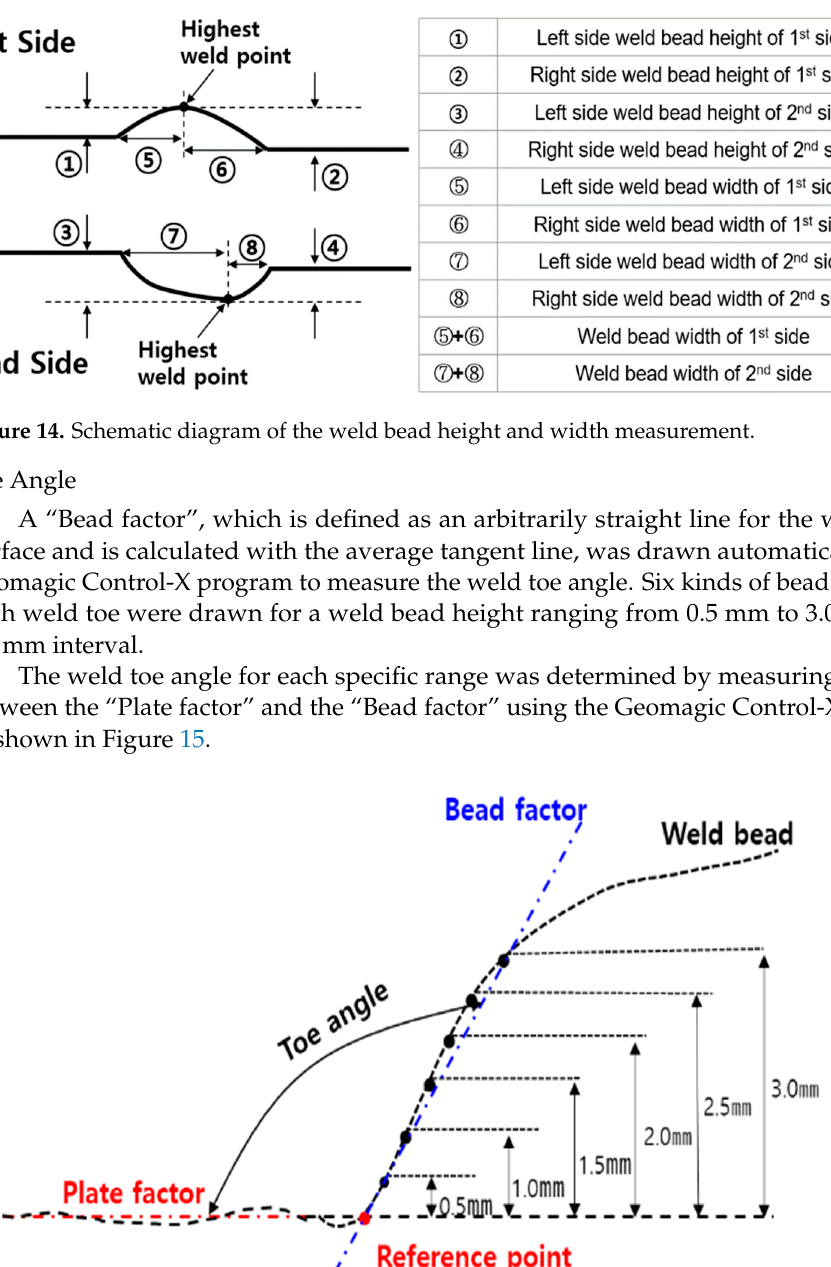
Figure 16. Schematic diagram of the angular distortion measurement. Trough Depth at the Toe Area Some troughs were found at the weld toe area when the extracted cross section con- sidered as the fatigue crack initiation point was investigated with large magnification. However, these troughs had not been detected by a visual inspection and M.T. The trough depth at each weld toe was determined by measuring the vertical distance between the “Plate factor” and the deepest point of the trough, as shown in Figure 17.